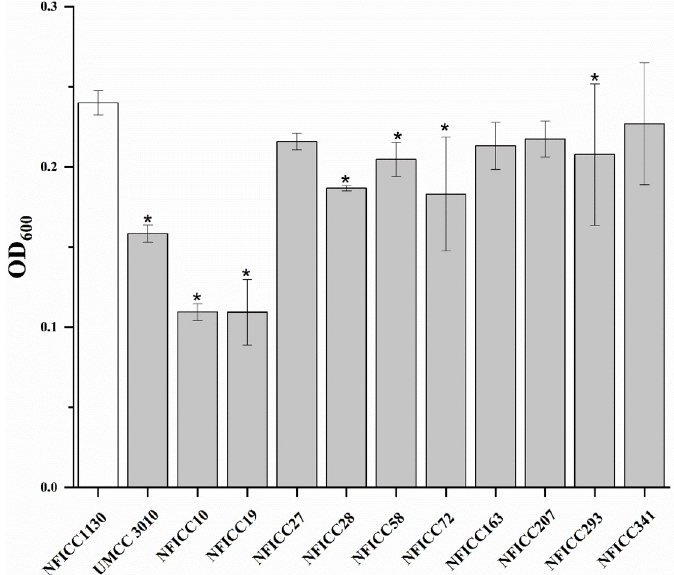
Figure 4. Antibacterial activity of the selected LAB’s cell-free supernatant in Bread Media (BM) on spoilage agent B. amyloliquefaciens NFICC1130. One-tail t- test was performed on the obtained triplicates comparing OD 600 value after 48 h growth of NFICC1130 in BM and the same pathogens challenged with CFS of L. plantarum (NFICC9, 27, 72, 163, 207, and 293), Lc. citreum (NFICC28), and P. pentosaceus (UMCC 3010, NFICC10, 58, and 341). Bars with * are significantly different, with a mean value significantly lower than the control sample (untreated sample), while samples NFICC 27, 163, 207, 293, and 341 respect the null hypothesis; t(2) = − 2.92 and p = 0.05.